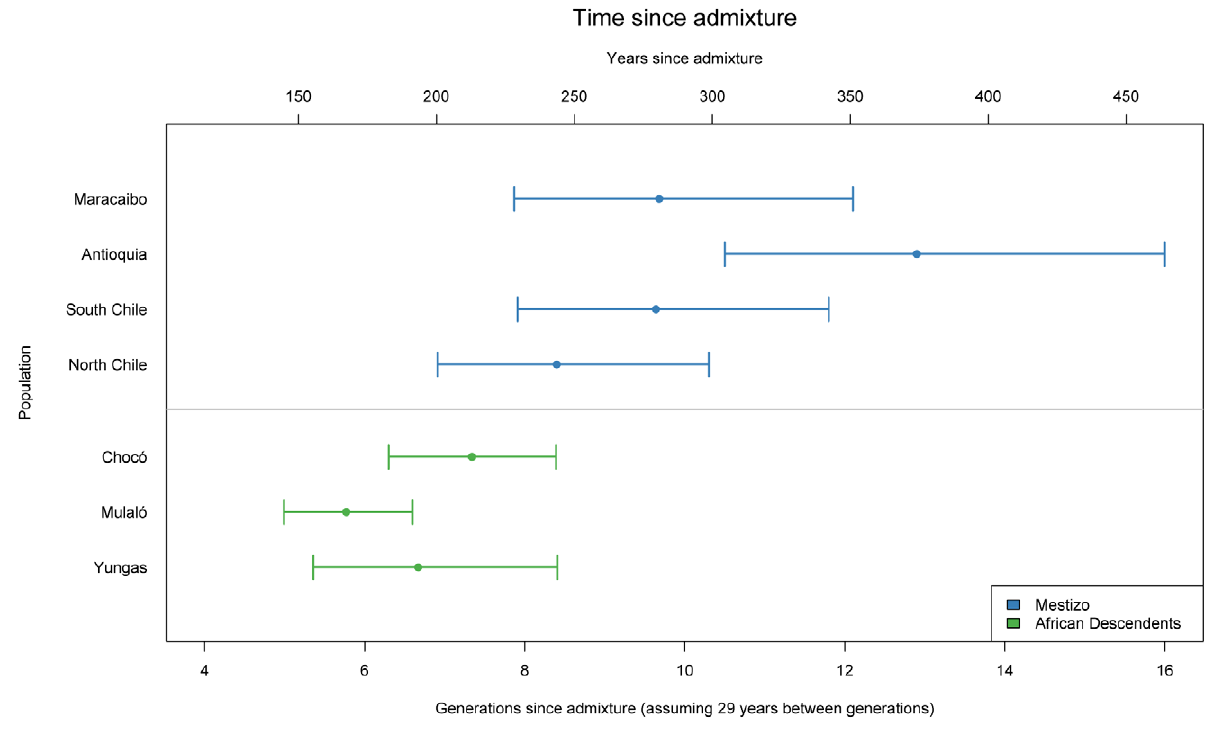
Figure 4. Time since admixture for Mestizo and African descendent populations.